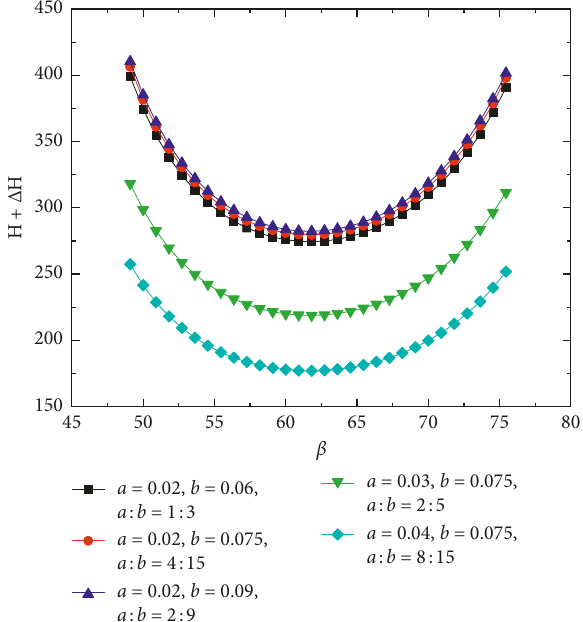
Figure 12: The limit heights of composite slope under different crack dip